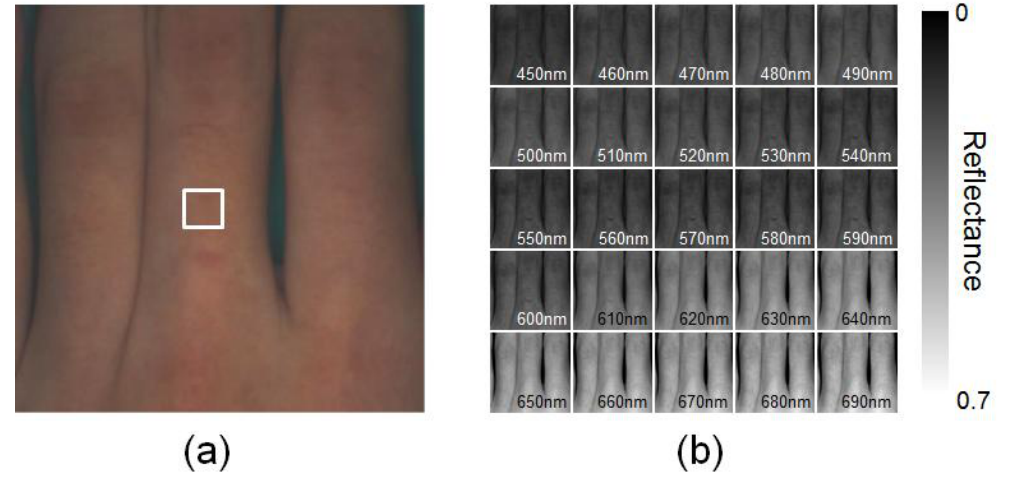
Figure 6. Comparisons of the estimated reflectance spectra averaged over the ROI (white square area in Figure 4) and the reference spectra measured by spectrometer for